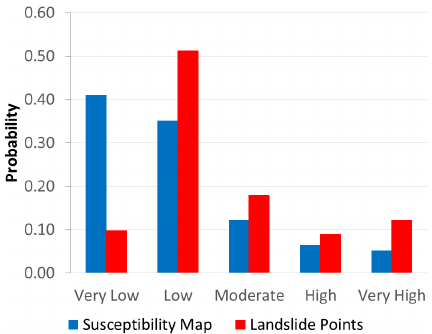
Figure 2. Probability distribution of susceptibility values at land- slide locations reported from 2007 to 2013 compared to landslide susceptibility values for all of Central America. Landslides occurred in all susceptibility categories, but few landslides ( < 10%) occurred in the lowest category. The LHASA model used a threshold of “low” susceptibility or greater (SI ≥ 2) with rainfall and antecedent rainfall thresholds within the decision tree framework (Fig. 6). SI ≥ 2 (low) was chosen to exclude a large portion of Central America without losing the ability to predict most landslide